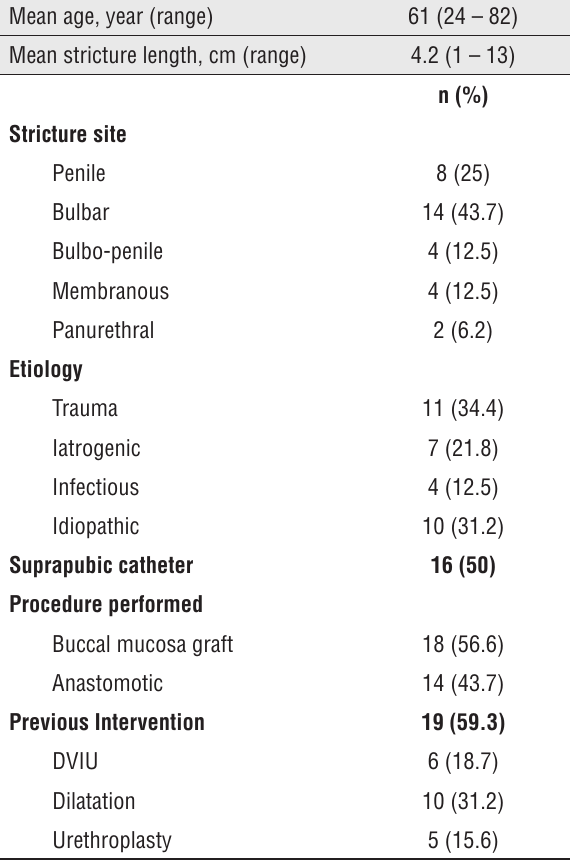
Table 1 – Baseline